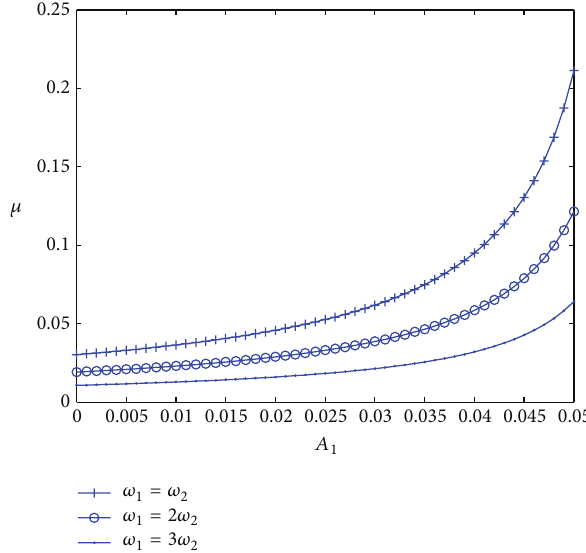
Figure 7: Correlation between 𝜇 and 𝐴 1 and 𝛽 1 = 0.01 , 𝛽 2 = 0.02 , and 𝐴 2 = 0.02 .